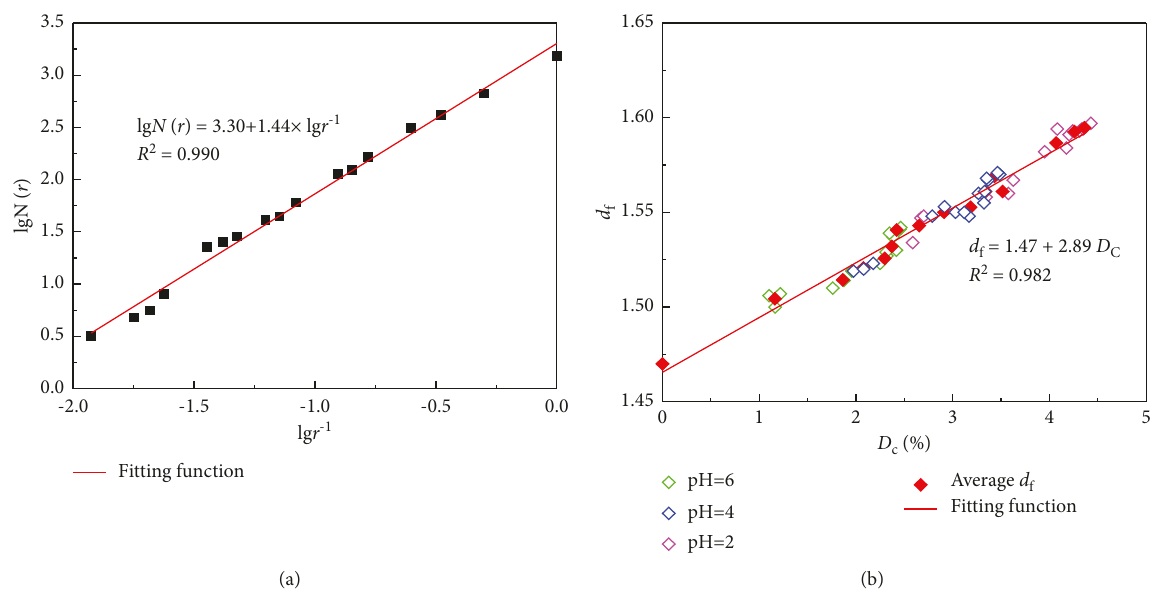
Figure 9: Fractal dimension calibration and results. (a) Plot of box-counting method applied to curved crack of typical fractured NSCB specimen; (b) variation in fractal dimension versus damage